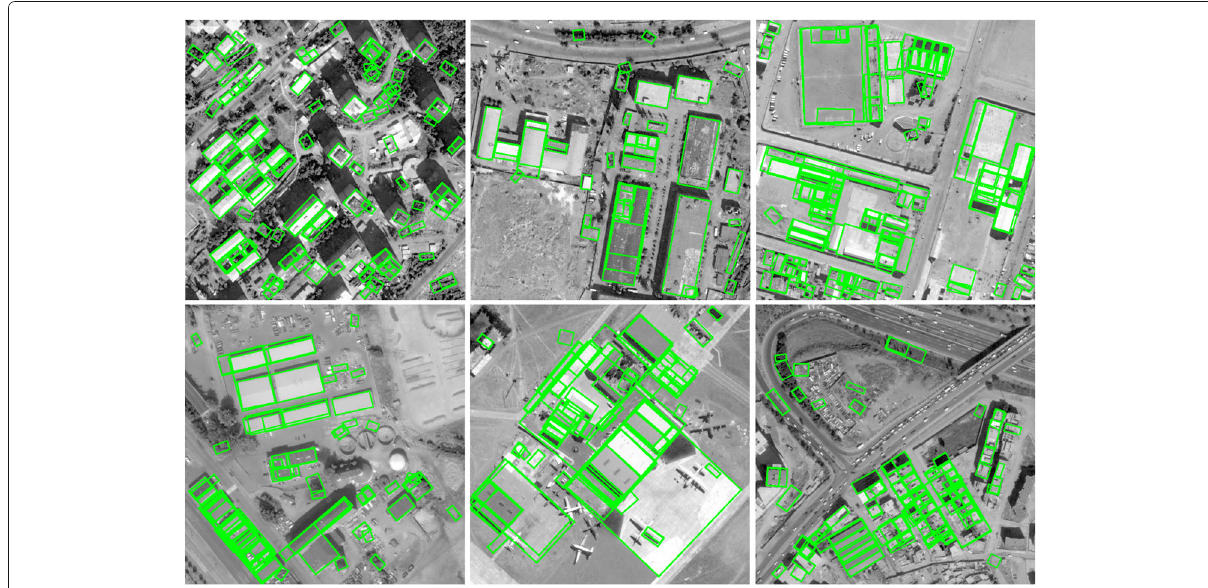
Fig. 29 Detected rectangles in the Fig. 27